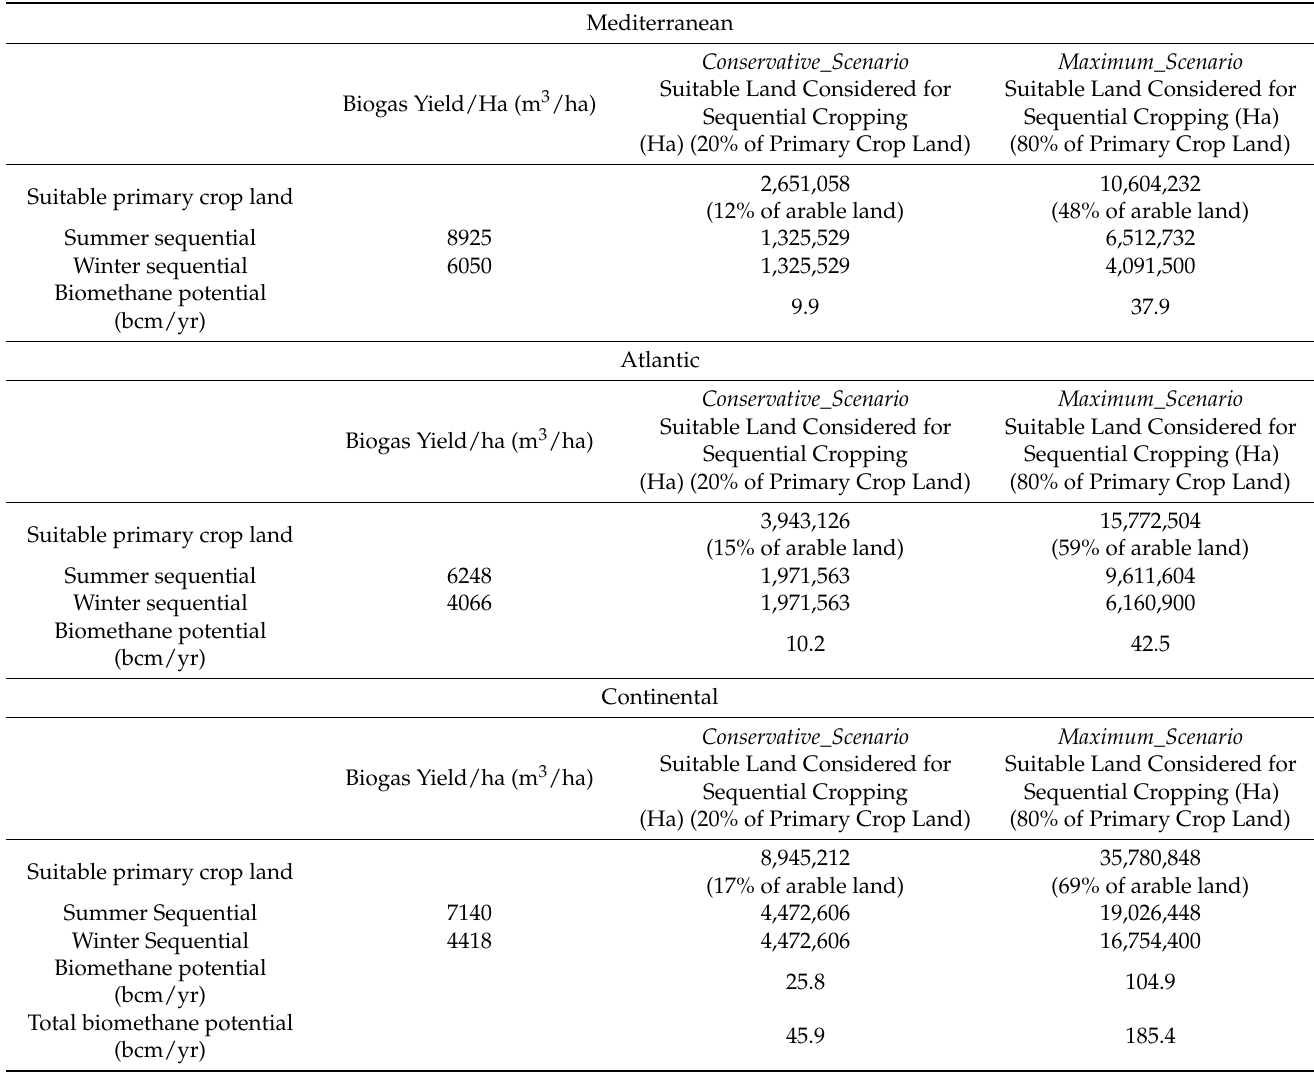
Table 4. Biomethane potential calculation for different EU climate regions.